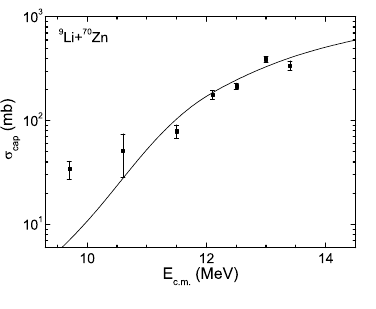
Figure 14. The calculated (solid line) and experimental (symbols) capture cross sections vs E c . m . for the reaction 9 Li + 70 Zn. The experimental data are from Ref.